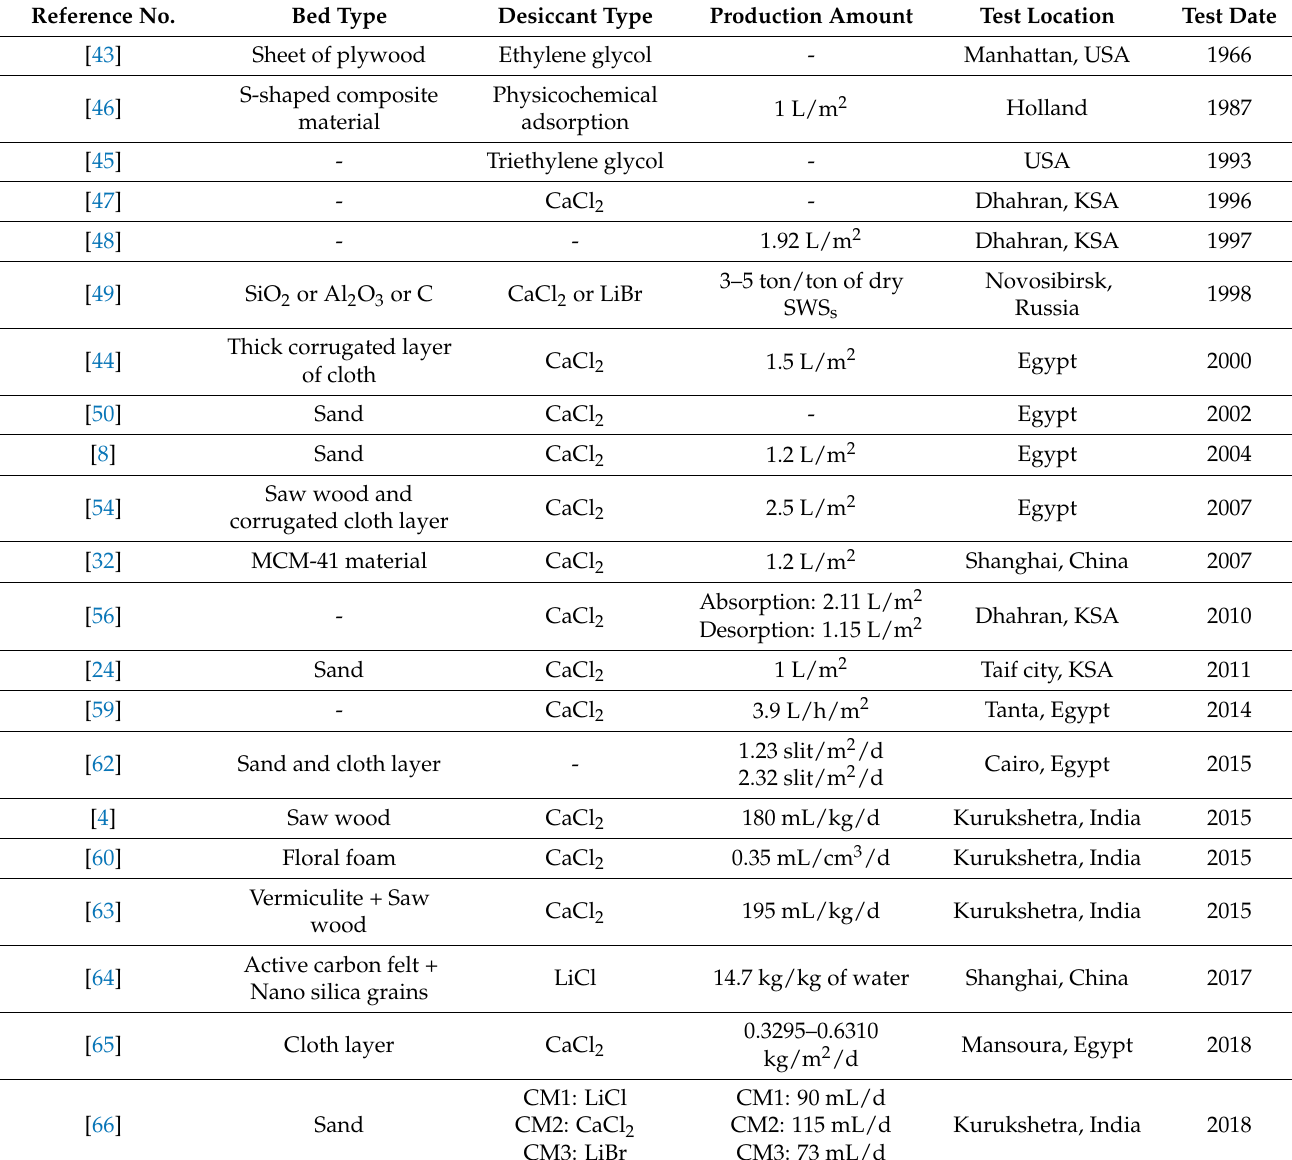
Table 1. Various strategies that have been published for extracting water from ambient air. Reference